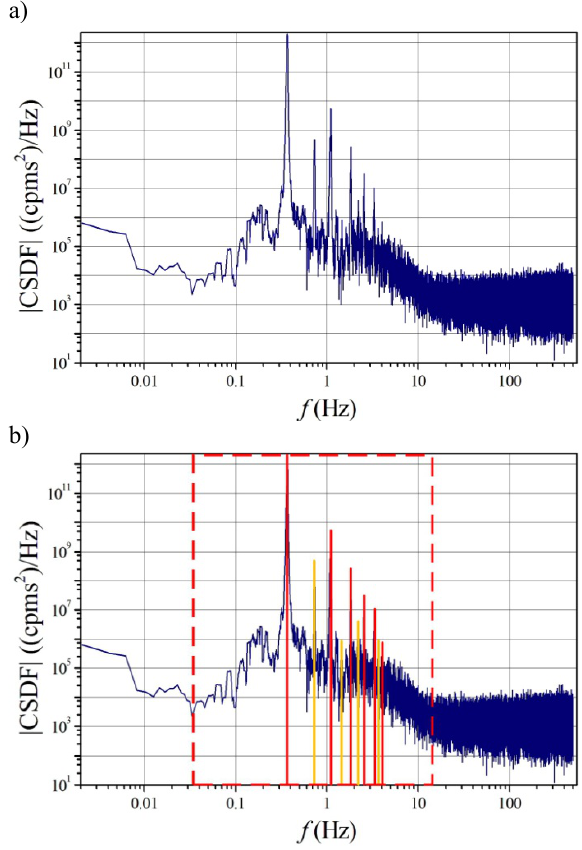
Fig. 6. The spectrum |CSDF| for slug flow (a); marked characteristic frequencies: red lines - the flow of large bubbles, orange lines - the flow of small bubbles, red frame shows the range of the useful frequencies